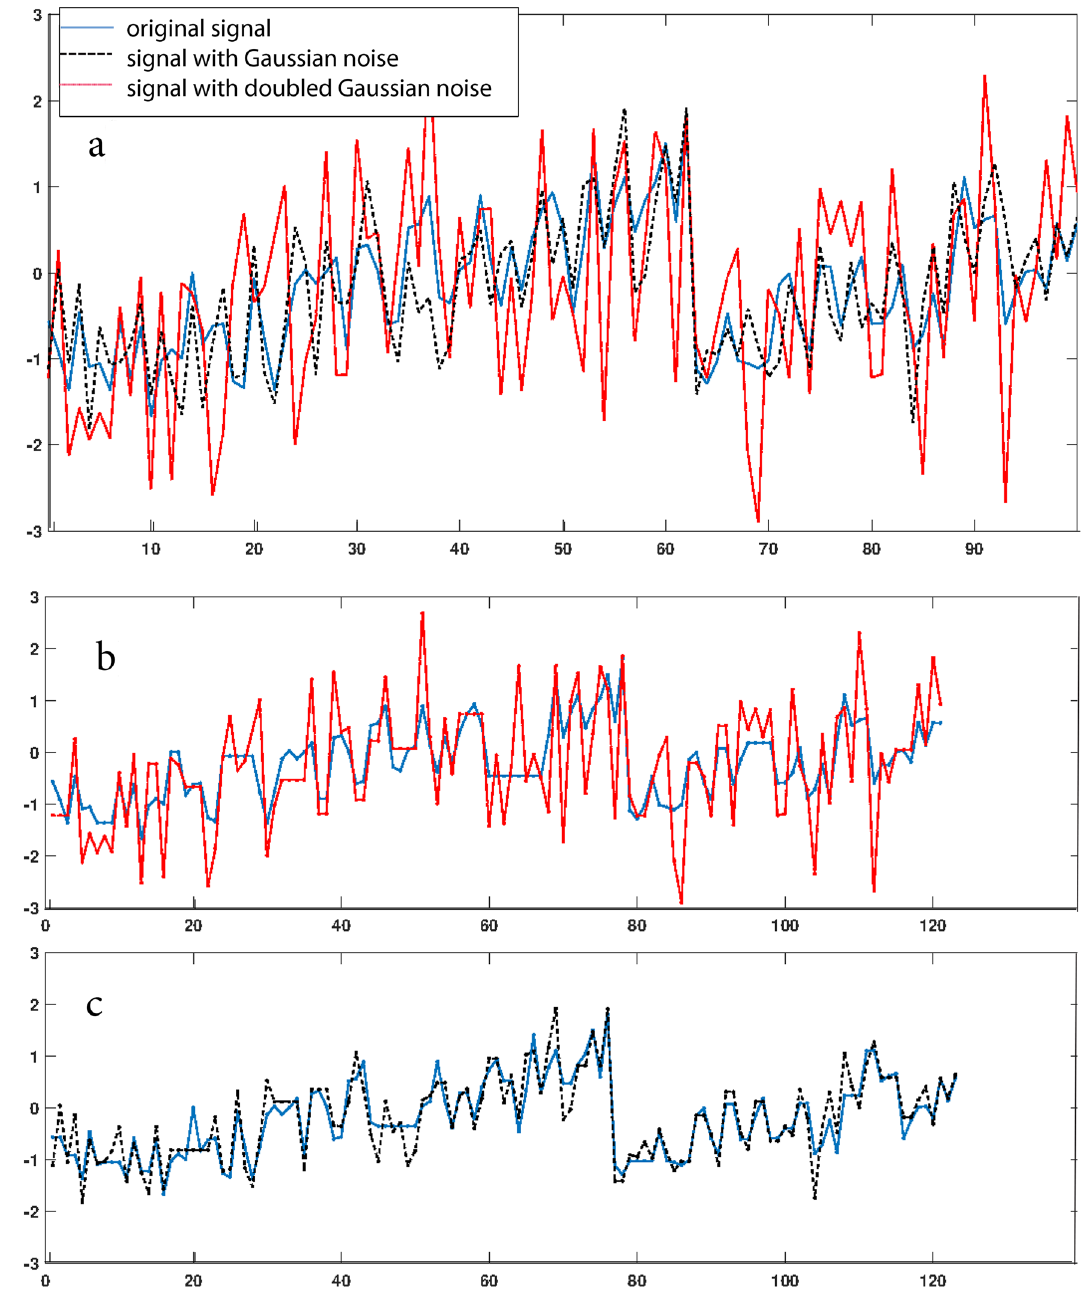
Figure 2. Calibration of DTWD effects: ( a ) Perturbed sawtooth wave (blue), the same upon the addition of white Gaussian noise (black, σ = 1 / 2 ) and, finally, of white Gaussian noise of doubled strength (red, σ = 1 ). ( b ) and ( c ) Signals after DTWD application (same